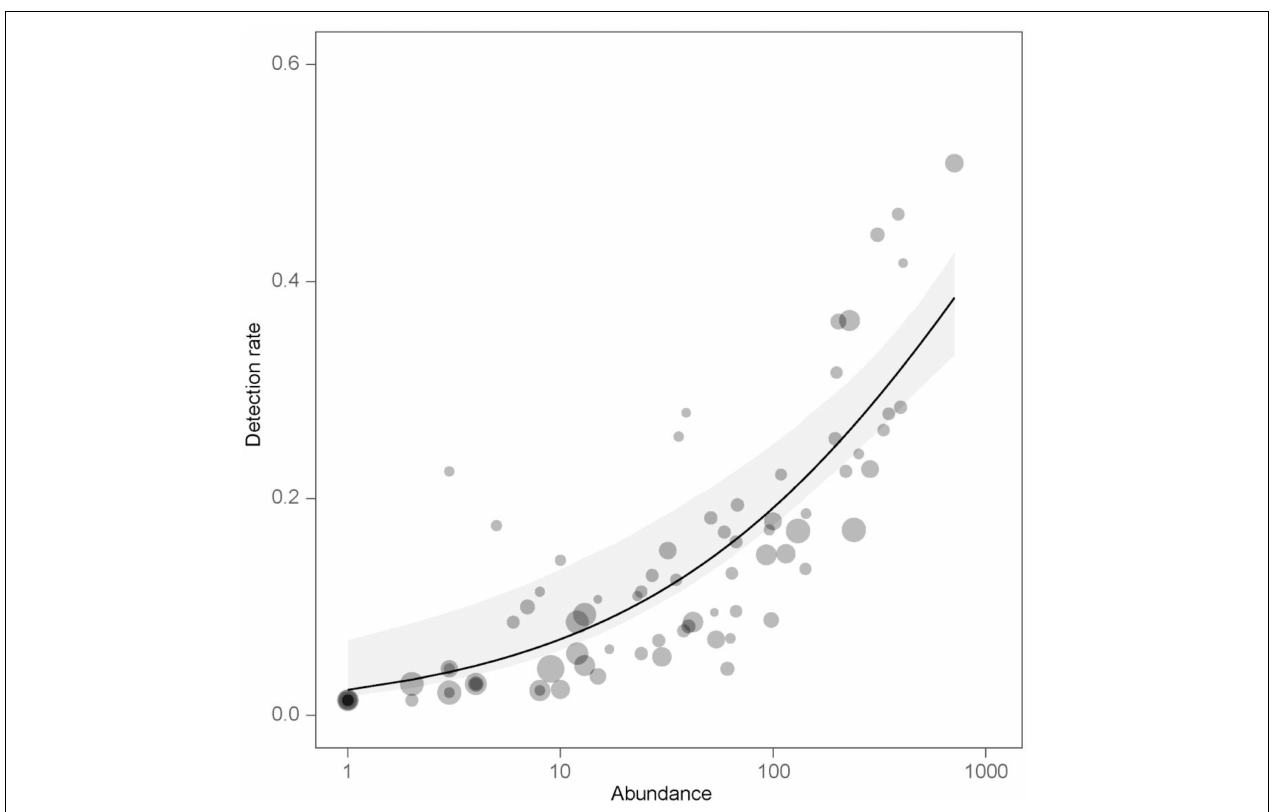
FIGURE 2 | The effect of species abundance on detection rates of bird species as predicted by the beta regression model. Observed values (dots) are displayed along with estimated detection rates (line) and 95% percentile bootstrap confidence interval of the estimate (gray band). Dot size is proportional to the body mass of a given species.